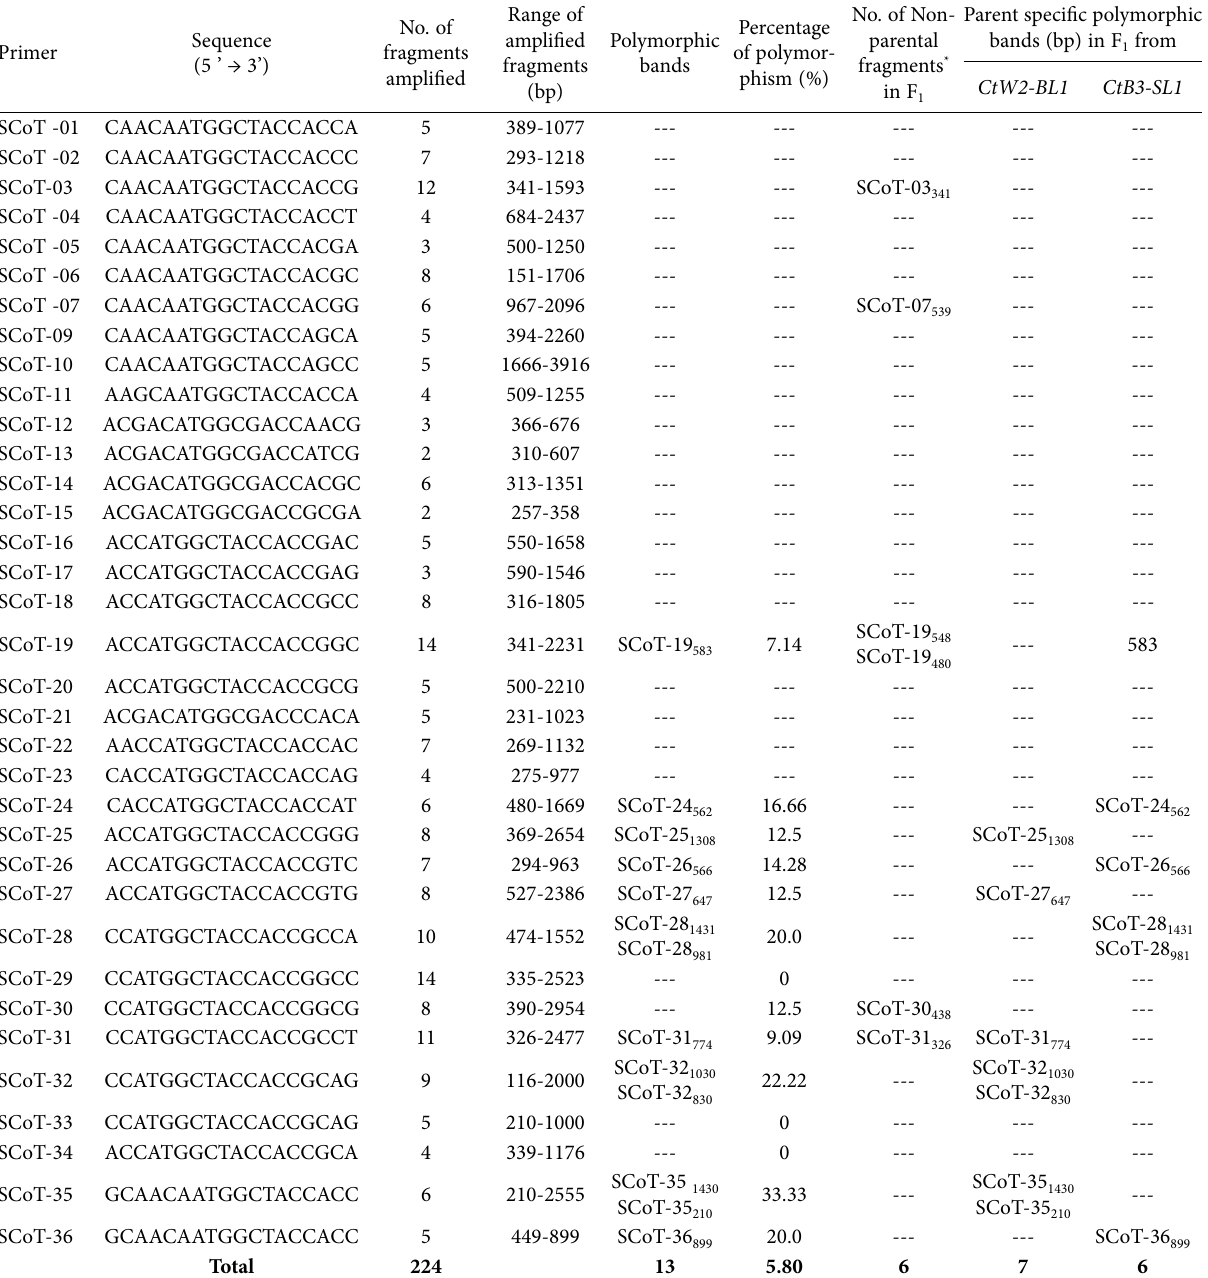
Table. 5. Details of SCoT markers used for characterization of intraspecific F 1 hybrid showing the inheritance of parent specific markers to the intraspecific F 1